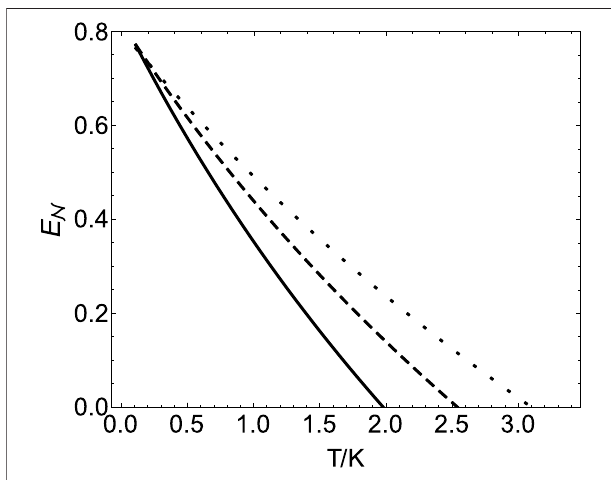
FIGURE 2 | Logarithmic negativity E N is plotted as a function of the normalization detuning Δ / ω m for different cavity frequencies ω c . The solid line refers to ω c (cid:1) 3 p ω 0 , the frequency corresponding to the dash line is 3 . 5 p ω 0 , and for the dotted line, ω c (cid:1) 4 p ω 0 . The temperature is T = 0.4.